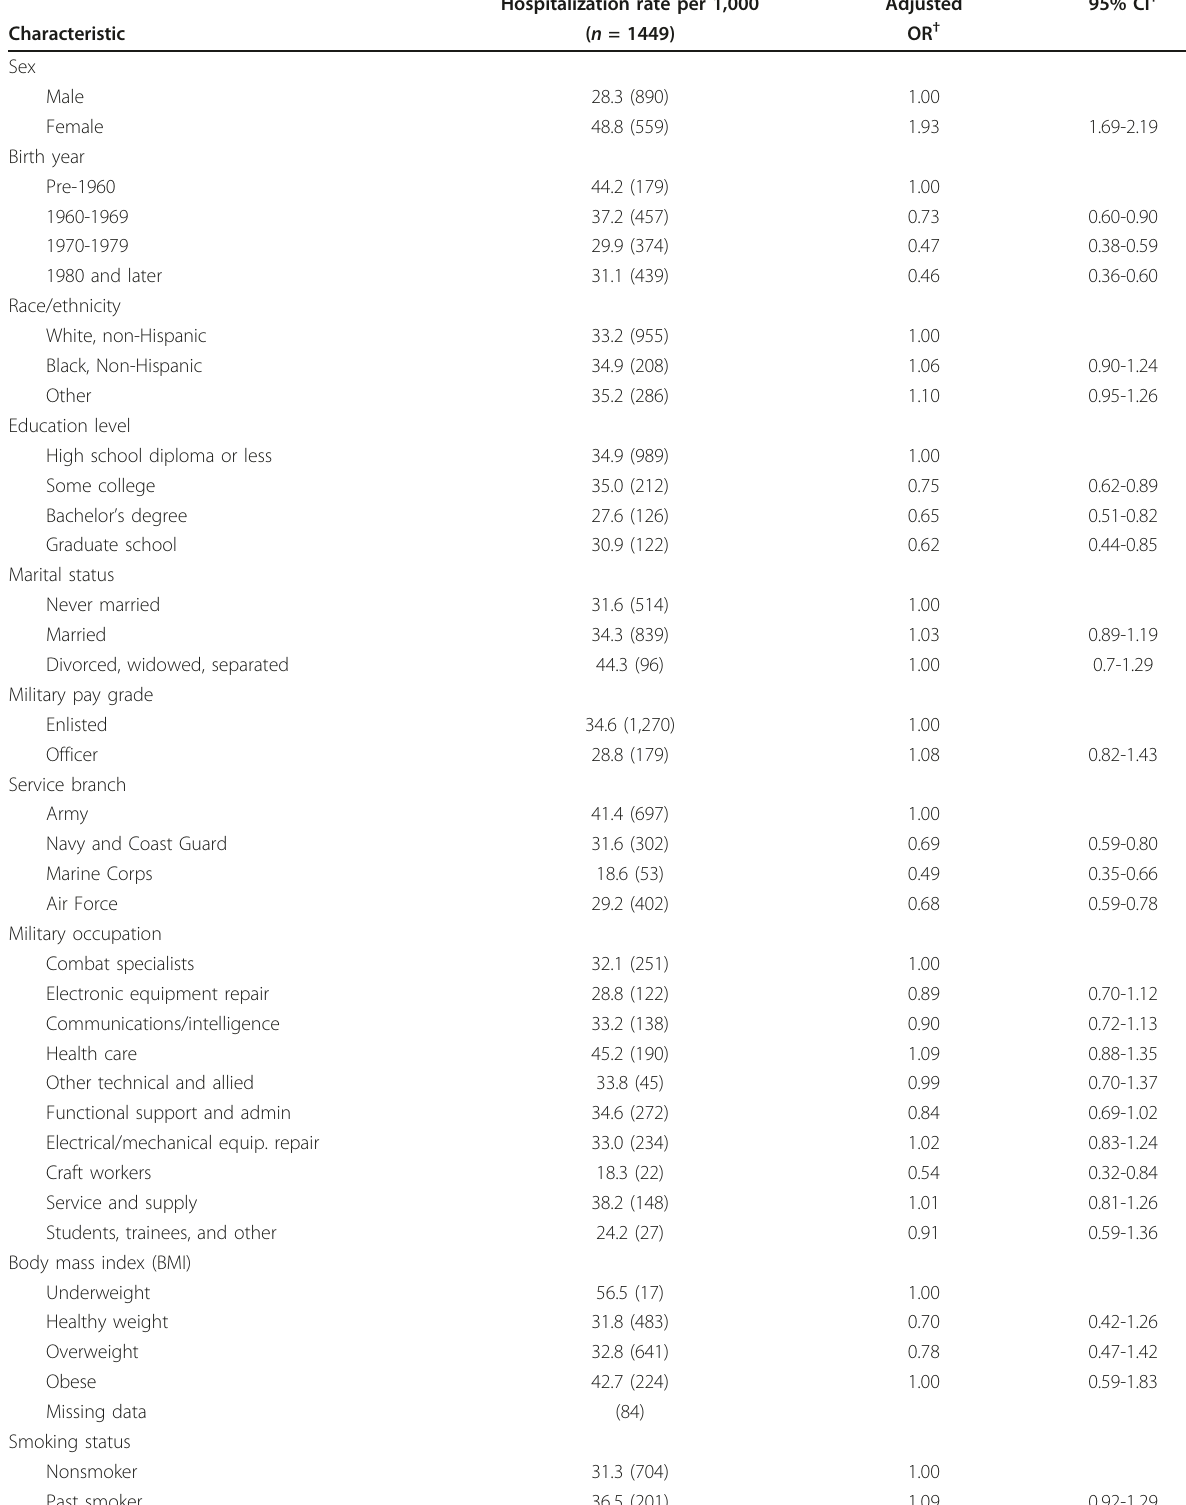
Table 2 First hospitalization rates and adjusted odds ratios for active-duty military personnel over a 1-year